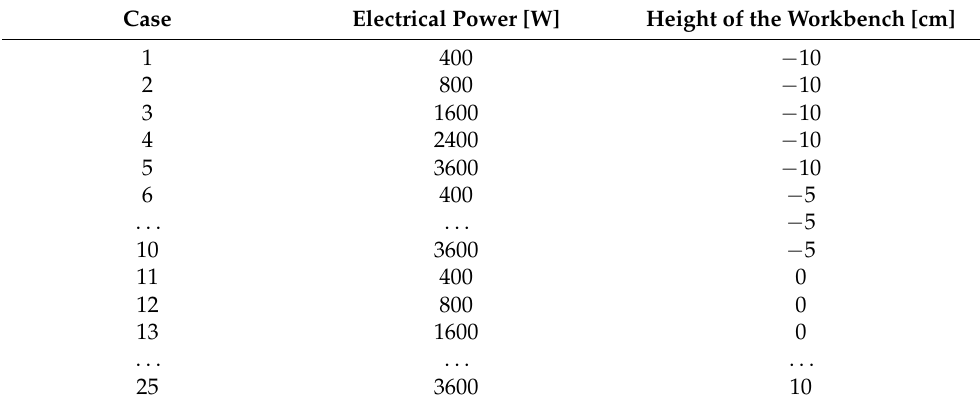
Table 3. Cases of experimental characterization.